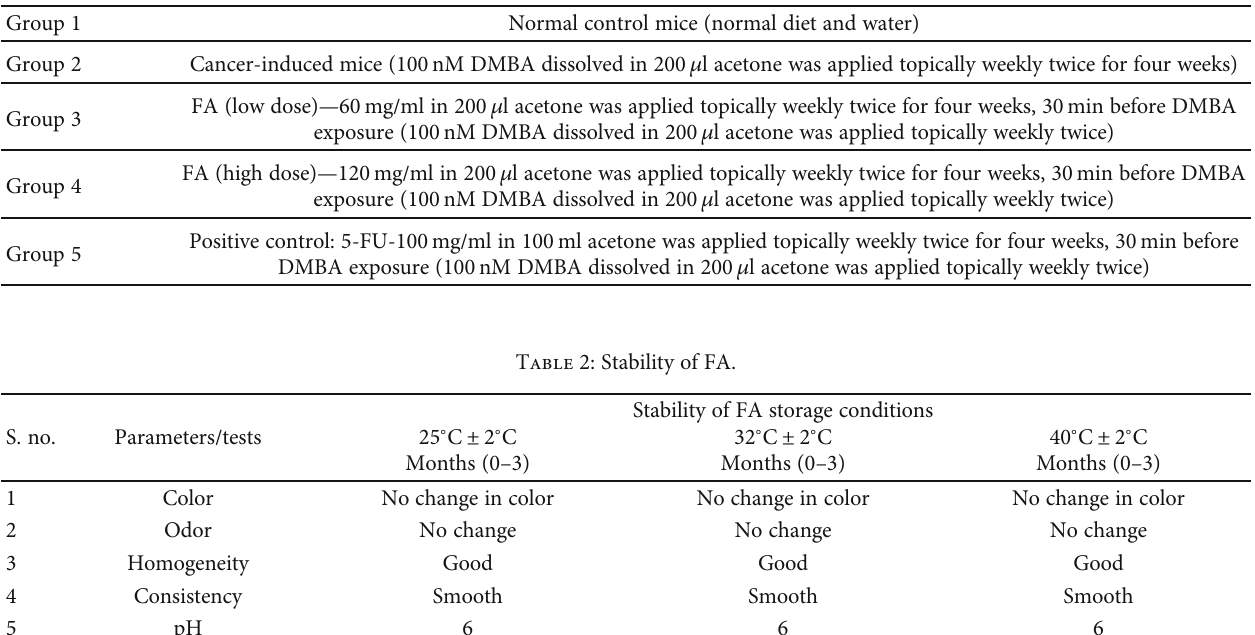
Table 1: Experimental design.